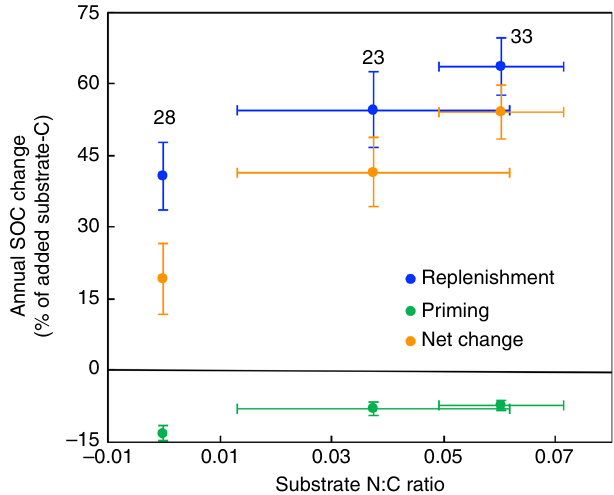
Fig. 5 Synthesis of the dependence of annual replenishment, priming, and net SOC change on substrate N:C ratio. The replenishment increased, but priming decreased, with the increase in substrate N:C ratio. Thus, the net SOC change signi fi cantly increased with the increase in substrate N:C